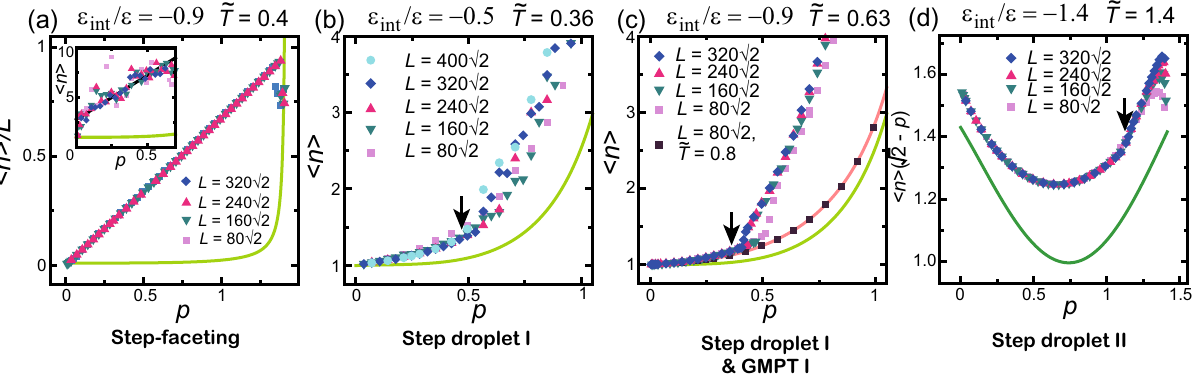
n Figure 4. Slope dependence of . The initial configuration has a single macrostep. ( a ) Step-faceting zone. (cid:31) (cid:30) Inset: results obtained from the initial configuration with separated elementary steps at equal distances. ( b